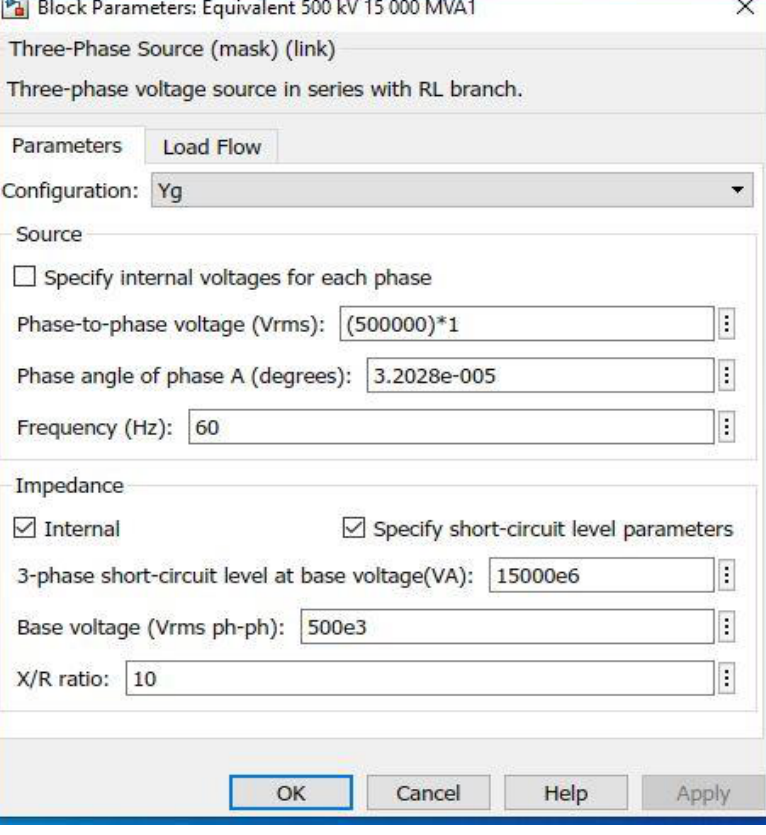
Figure 15. Parameters setting of 15,000 MVA Biomass generation Block.